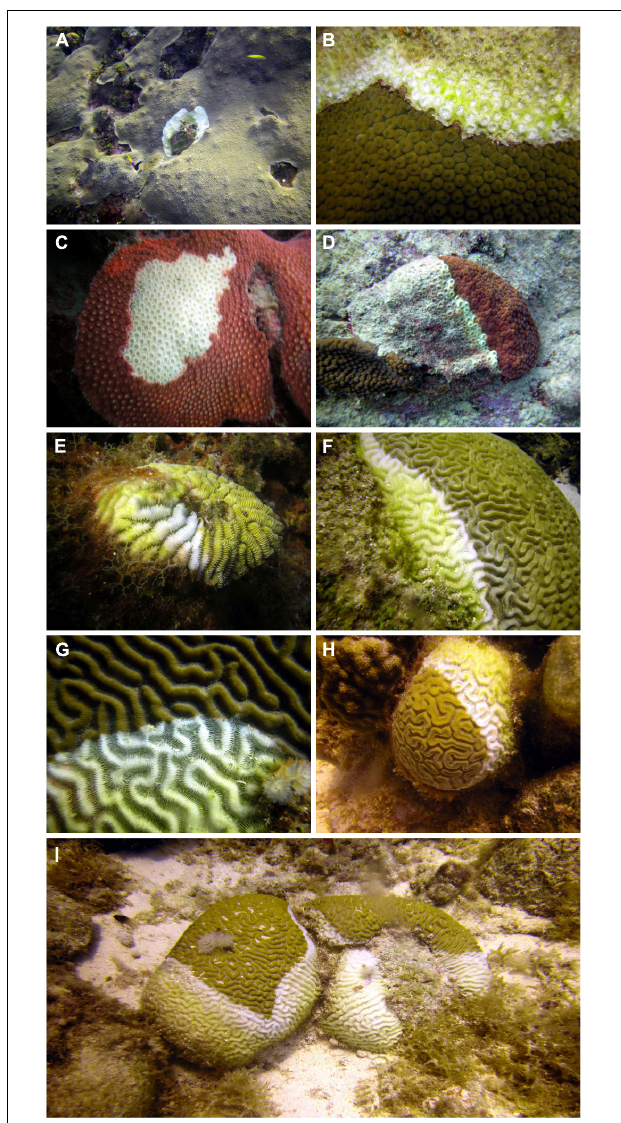
FIGURE 3 | Photos of classic description of WPD-II lesions in different localities of the Caribbean. (A) Focal lesion starting from a depression of an Orbicella faveolata in Cayman Islands (Summer of 2006) and on the center of a Montastraea cavernosa (B) in Curacao (Summer 2005). (C) Secondary algal growth behind active WPD-II active front affecting Montastraea cavernosa in Curacao in 2006. Examples of focal lesions starting at the base of colonies and moving upward in Montastraea cavernosa ( D : Bermuda, Summer 2006), Meandrina meandrites ( E : Curacao, Summer 2005), Pseudodiploria strigosa ( F, G : Curacao, Summer 2006) and Diploria labyrinthiformis ( H : Curacao, Summer 2006). Two P. strigosa colonies close to each other showing a lesion starting from the base and moving upward the colonies ( I : Curacao: Summer 2006). Photos A.